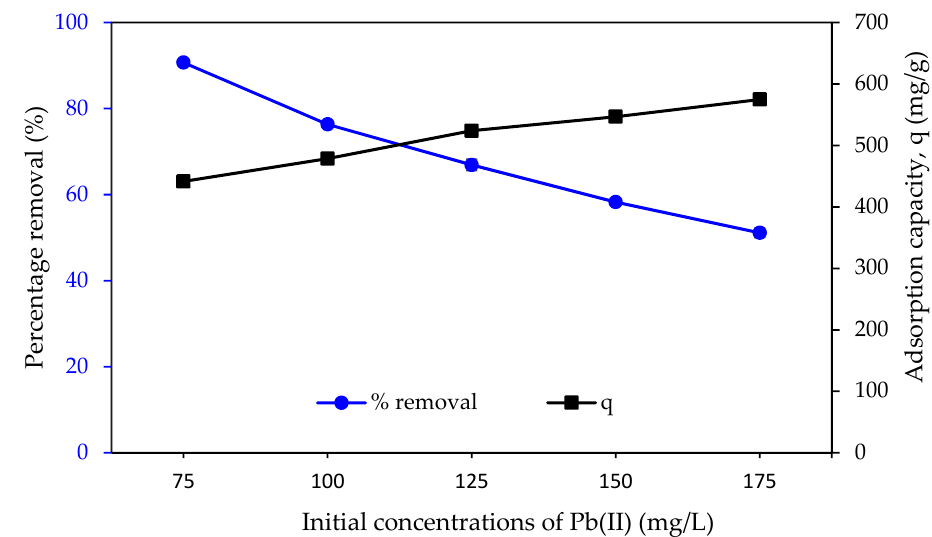
Figure 12. Effect of initial Pb(II) concentration on the percentage removal. Condition: pH = 5, dosage of adsorbent = 40 mg, contact time = 240 min.